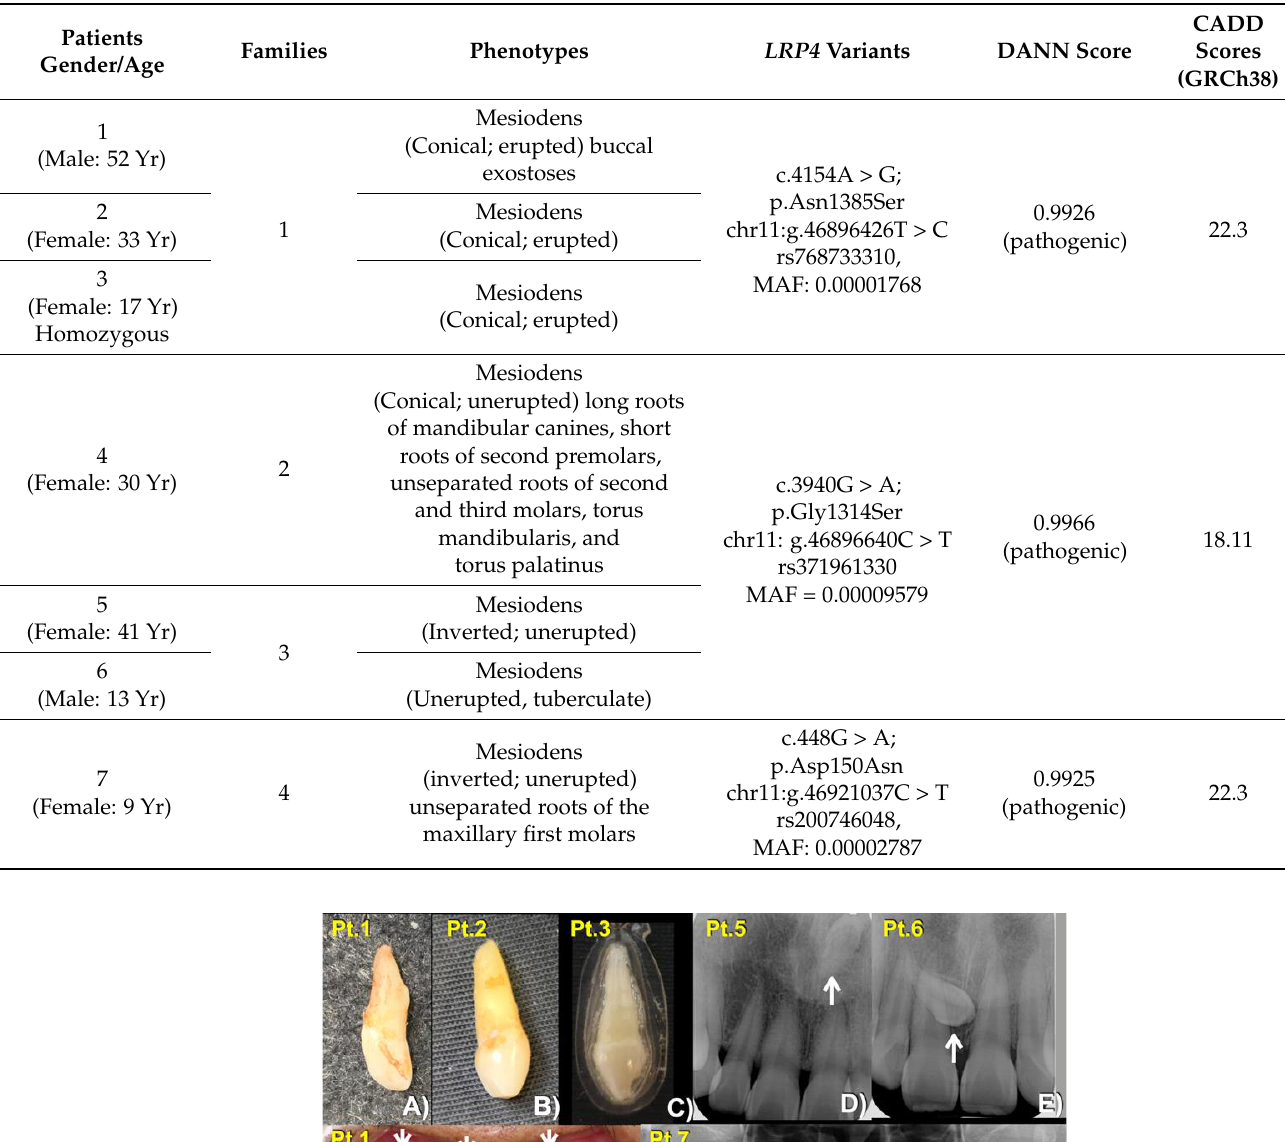
Table 1. Patients with LRP4 Variants and their phenotypes. All patients have mesiodens with or without root maldevelopments and oral exostoses. Where known, the orientation and eruption status are shown for each. Patient 3 was homozygous for the p.Asn1385Ser variant, the other six patients were heterozygous for LRP4 variants. Patients 2 and 3 are daughters of patient 1. Patient 6 is the son of patient 5. Genomic coordinates are based on GRCh37. RefSeq accession numbers NM_002334.4; NP_002325.2 Genomic coordinates are given relative to GRCh37v1.6.